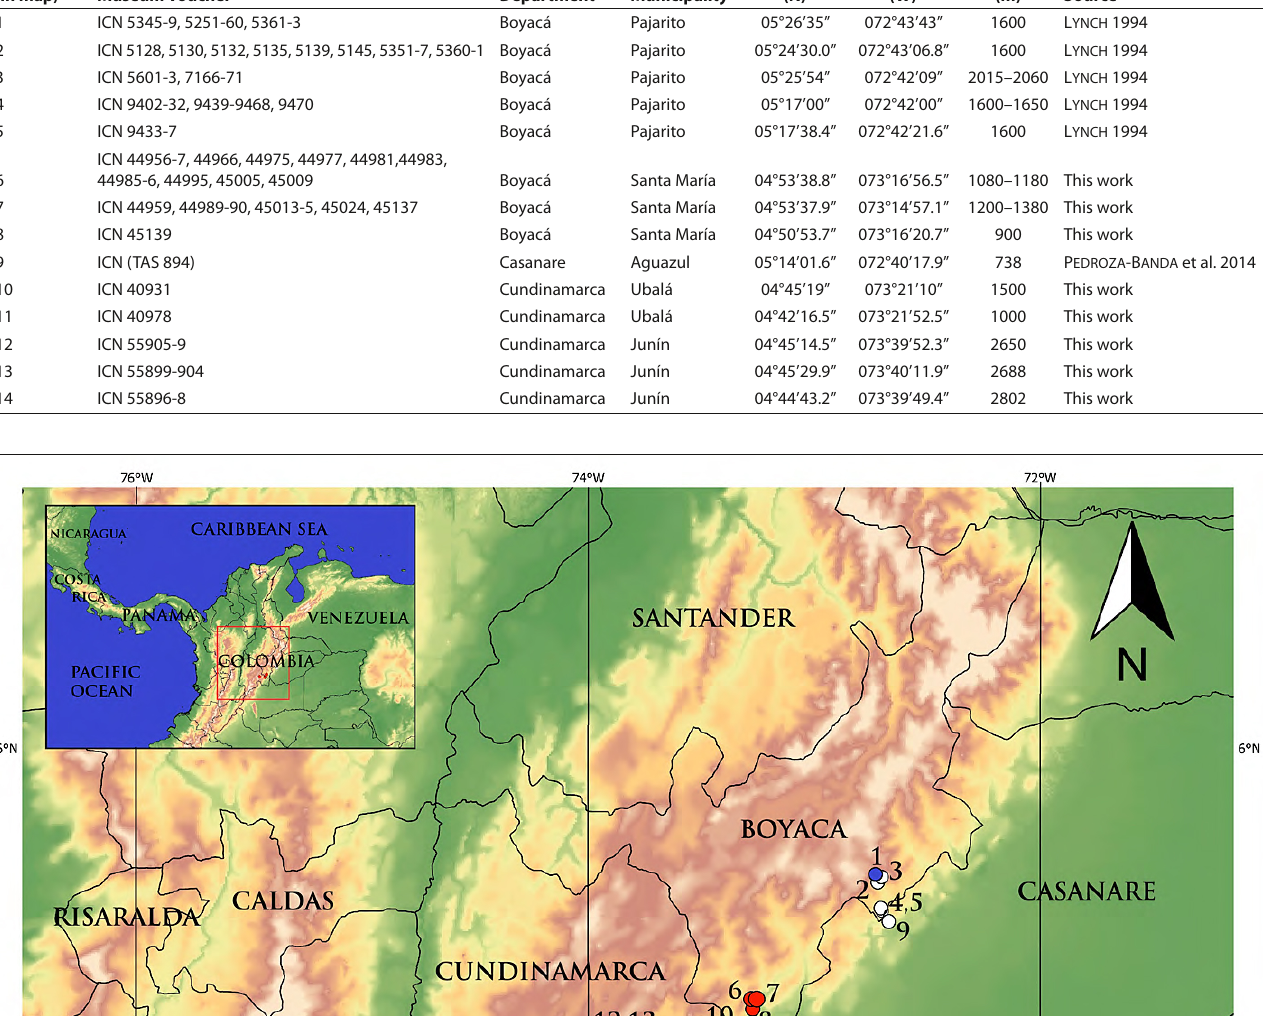
Table 1. List of all known specimens of Pristimantis carranguerorum (Lynch, 1994) separated by locality. All vouchers are deposited in the ICN collection, including the uncatalogued specimen with field number TAS (Teddy Angarita-Sierra) 894. Locality no. (in map)